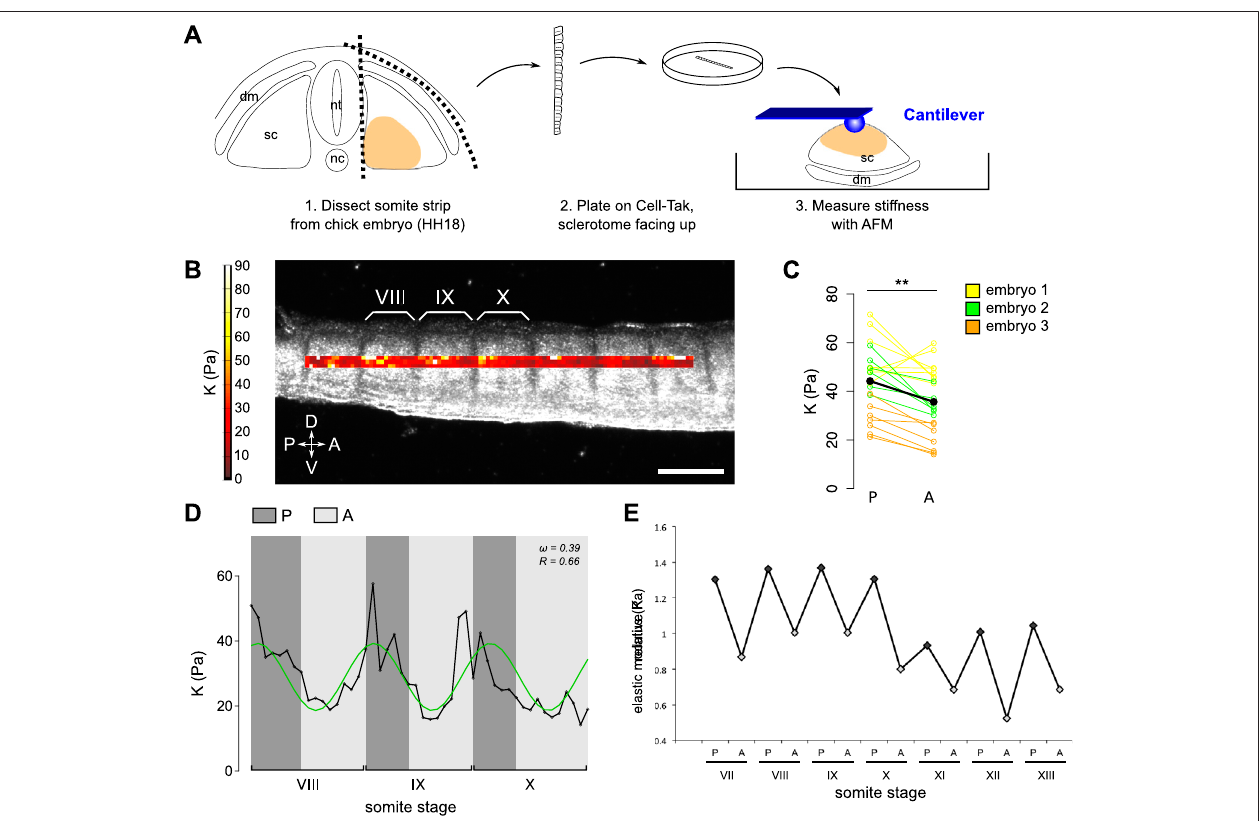
FIGURE 2 | Posterior half-sclerotomes are stiffer than anterior half-sclerotomes. (A) Schematic representation of work fl ow to measure sclerotome stiffness with AFM. dm:dermomyotome; sc:sclerotome; nt:neuraltube; nc: notochord. The coloredregionistheregion ofinterestforAFM-based measurements. (B) Image ofchick embryowithoverlaidAFM-basedstiffnessmapofsclerotometissuealongtheantero-posterioraxis.ColorencodestheapparentreducedelasticmodulusKassessedat an indentation force of 3 nN. Somite stage is indicated in roman numerals. Scale bar: 200 μ m. Sclerotome tissue displayed a periodic stiffness gradient corresponding to the spatial periodicity of anterior and posterior halves. (D) dorsal; V: ventral; P: psoterior; (A) anterior. (C) Mean K in anterior half-sclerotomes (A) and in correspondingposteriorhalf-sclerotomes(P)in21sclerotomesofthreeembryos.Theblackdotsrepresentthemeanofallvalues.Sclerotomesweresigni fi cantlystifferin the posterior half compared to their anterior half, along which axons grow (paired t -test, ** p = 0.0012). (D) Stiffness distribution for three consecutive segments (somite VIII, IX, and X). The black line represents mean K at each 15 μ m step along the antero-posterior axis, the green line represents the sinusoidal regression of the data. The plot is representative of N = 5 embryos. (E) Example of relative elastic modulus K values along the antero-posterior axis as a function of somite stage, showing that posterior halves are stiffer than anterior halves at least from somite stage